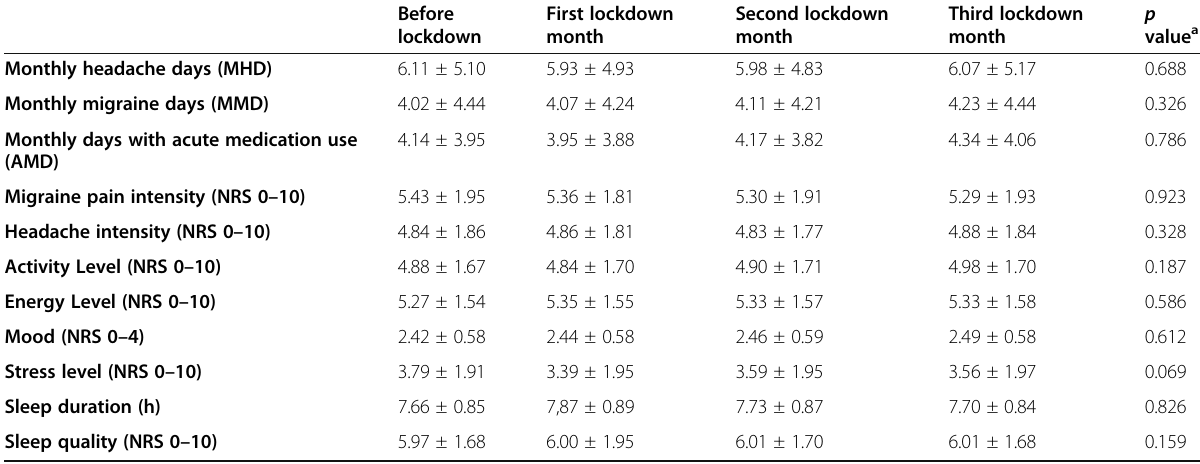
Table 2 Headache characteristics and potential trigger factors before lockdown begin and in the first 3 months of lockdown in Germany